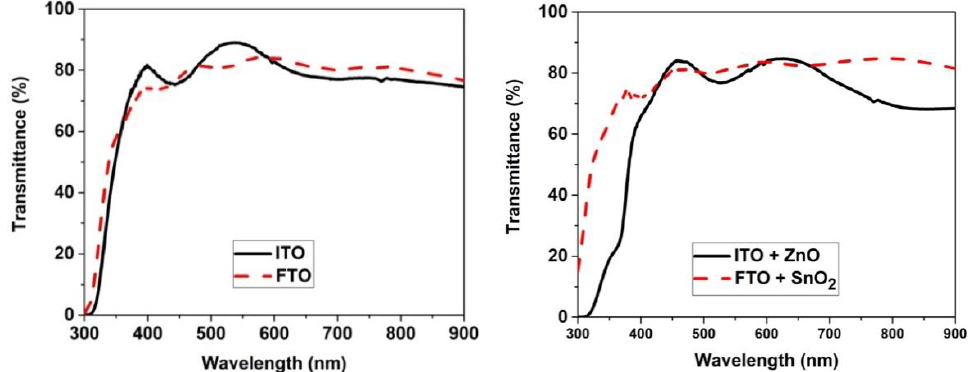
Figure 2. Transparency of ITO and FTO in comparison ( left ) and with their respective high resistive layer ( right ).